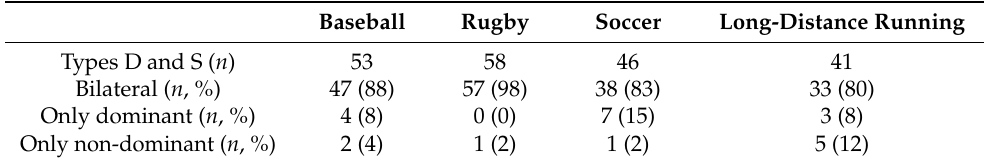
Table 3. Frequency of bilateral, only dominant, or only non-dominant cases among participants with hypermobility of the ulnar nerve.